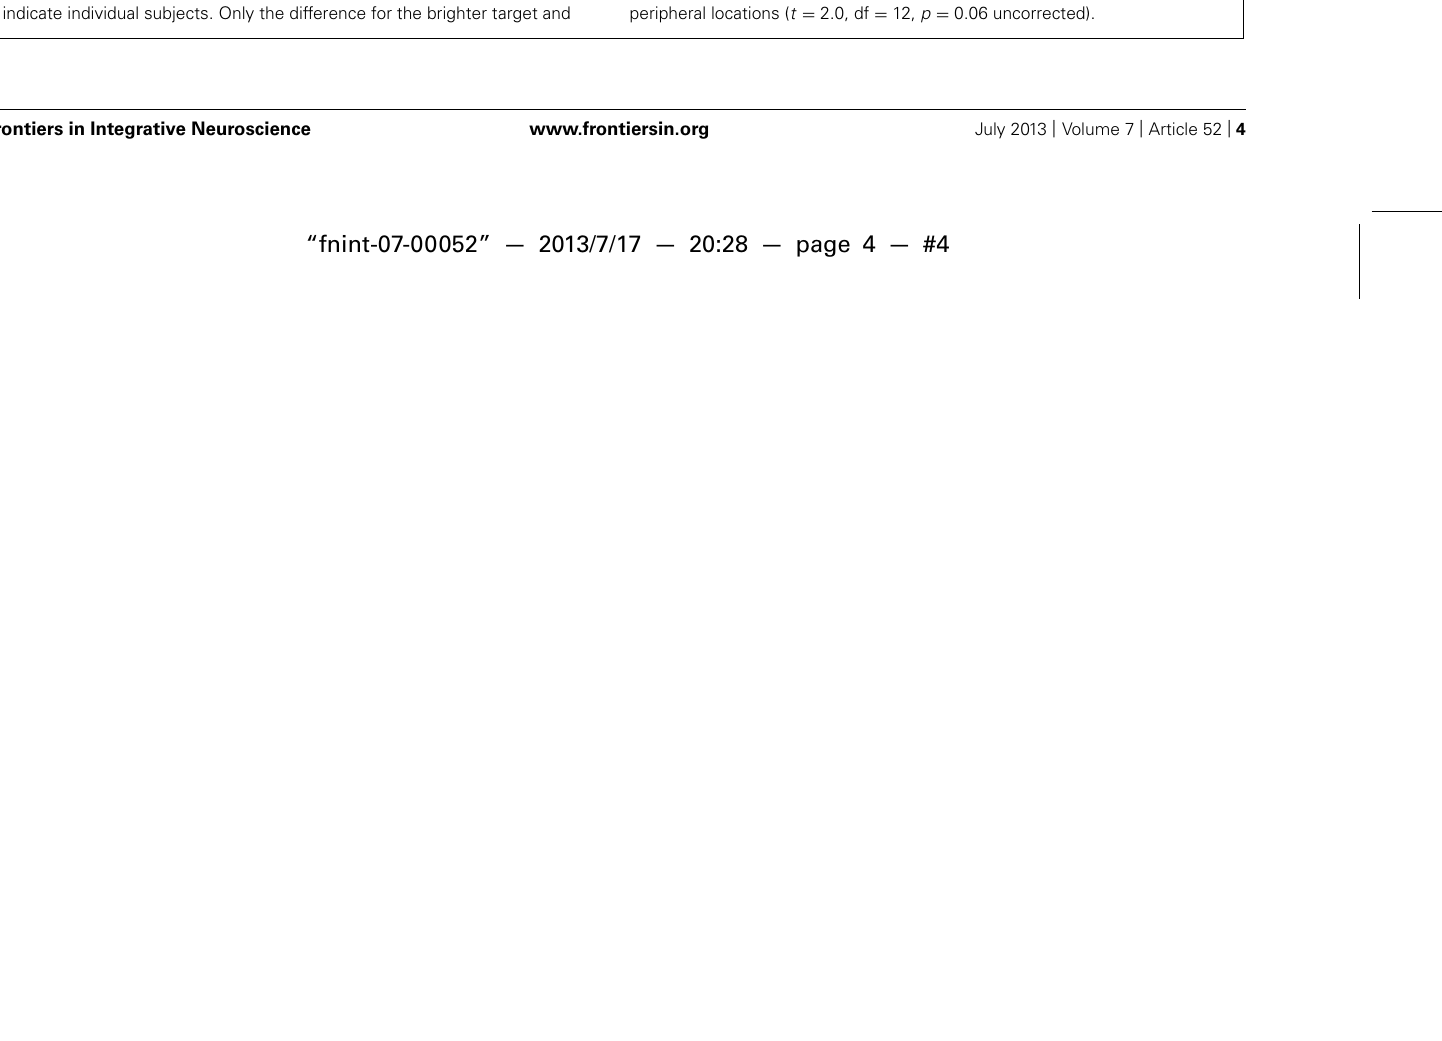
FIGURE 2 | Results for detection (A,B) and discrimination tasks (C,D). (A) Group level performance for the detection task, separately for each target brightness and eccentricity (mean and SEM; n = 13). Overall performance did not differ between eccentricities but was higher for the brighter targets as expected. (B) Contrast between informative and non-informative sounds for the detection task. Bars denote group level results (mean and SEM), dots indicate individual subjects. Only the difference for the brighter target and